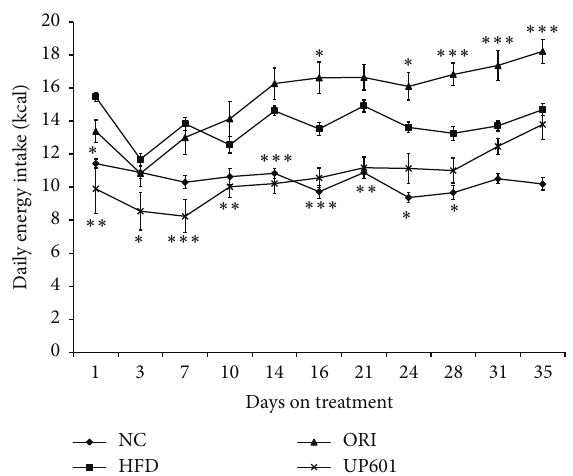
Figure 4: Daily calorie intake by obese mice treated with oral doses of UP601 at 1.3 g/kg in the DIO model. ∗∗∗ 𝑃 ≤ 0.0001 ; ∗∗ 𝑃 ≤ 0.001 ; ∗ 𝑃 ≤ 0.05